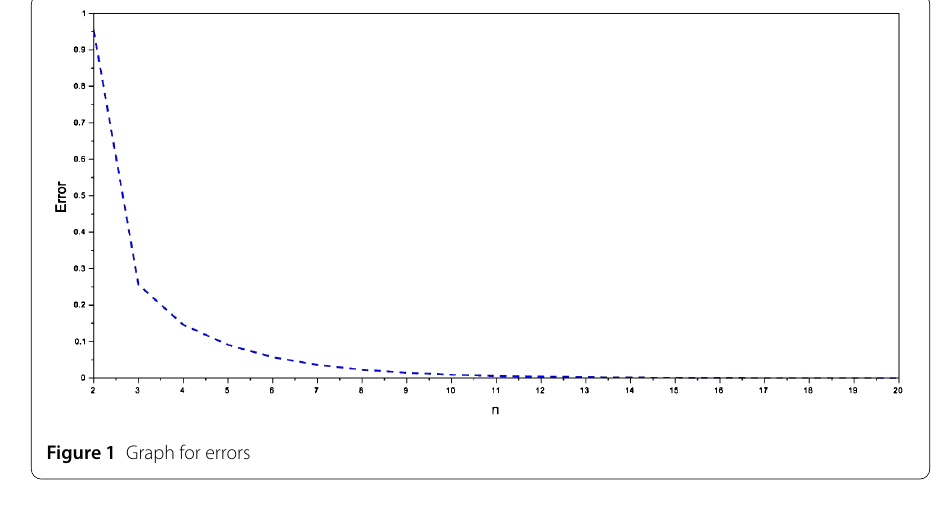
Figure 1 Graph for